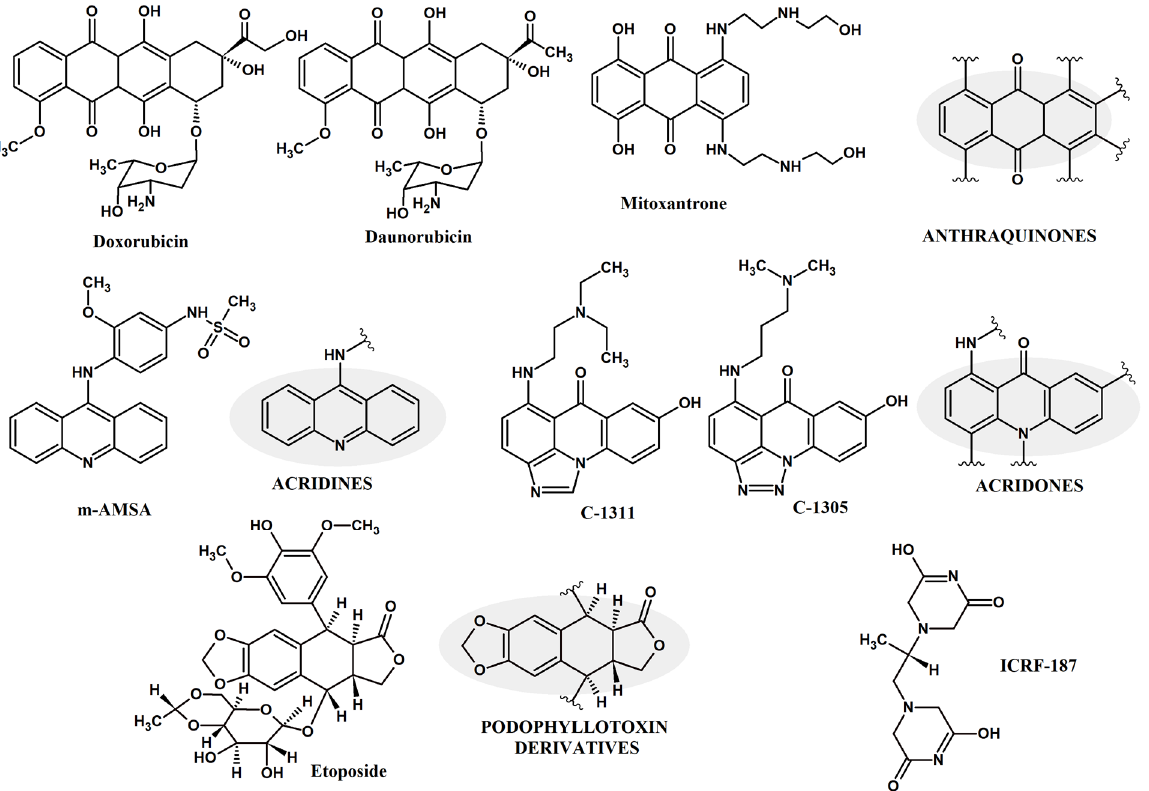
Figure 1. Selected compounds that either act as intercalators or interrupting agents to human topoisomerase II from the group of anthraquinone, acridine, acridone or podophyllotoxin derivatives and ICRF-187.